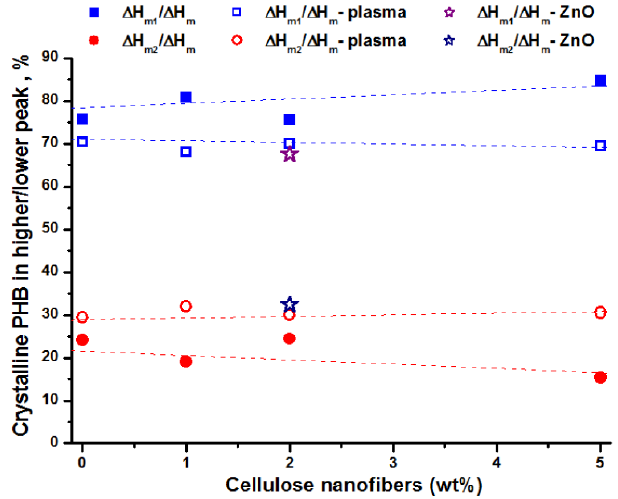
Figure 7. Influence of cellulose nanofibers concentration and plasma treatments on the proportion of crystalline PHB with lower (upper squares) and higher melting temperature (lower circles).